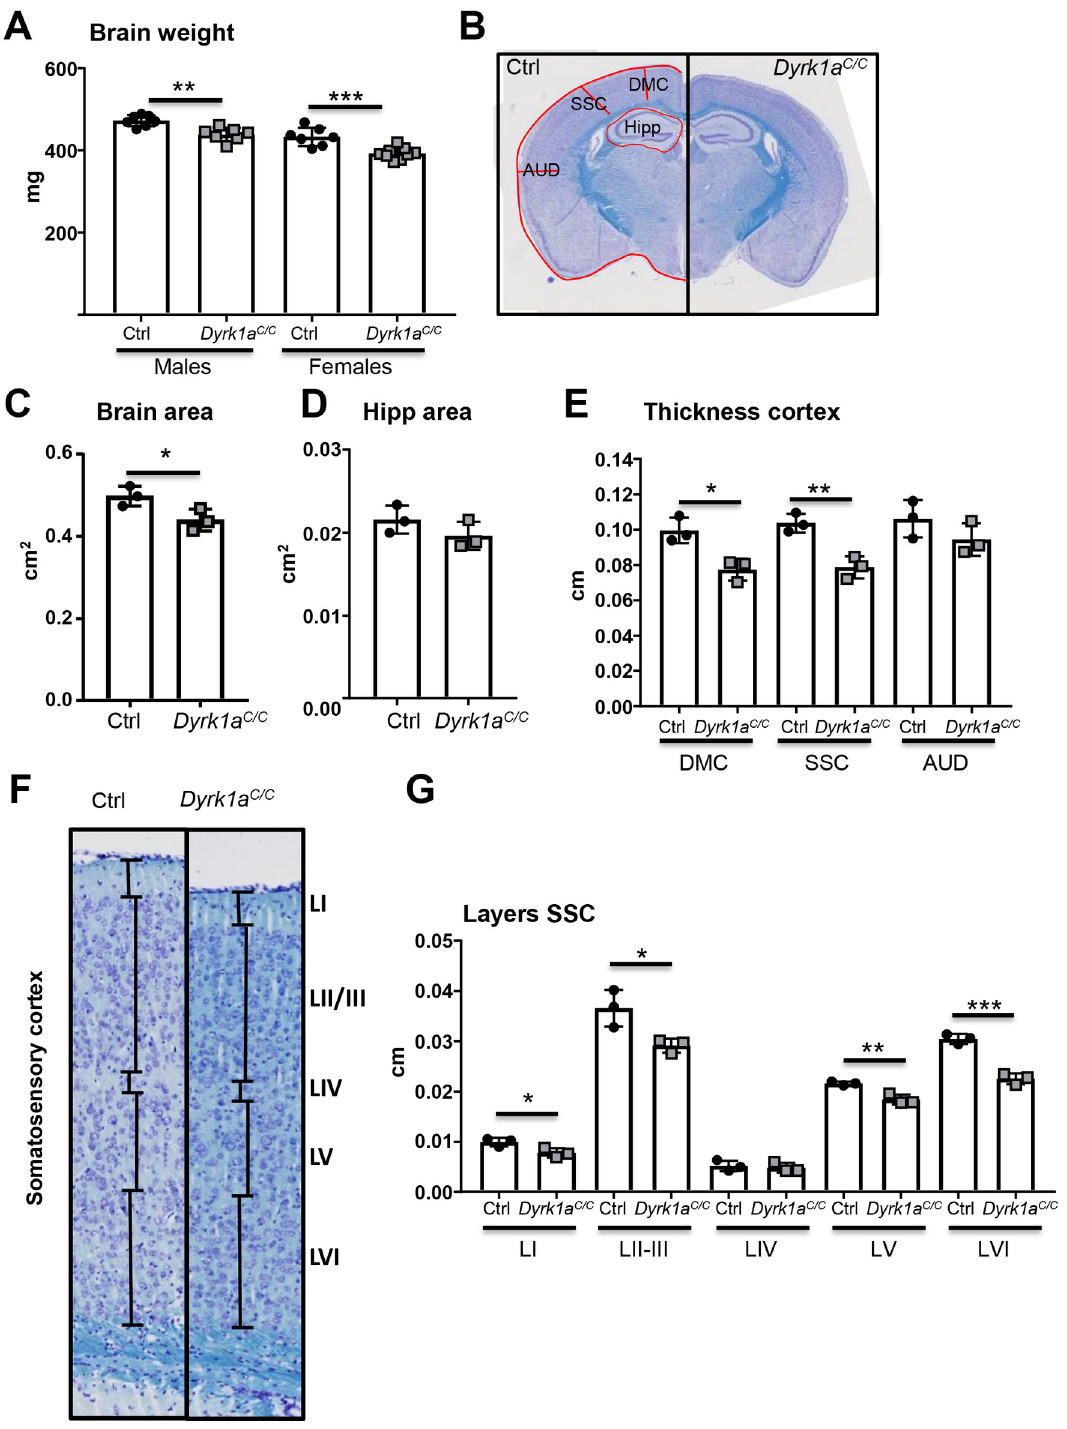
Fig 2. Consequence of Dyrk1a inactivation in glutamatergic neurons on brain morphology. (A) Brain weight from male and female mice aged 3 months old (n = 7–9 per genotype). (B) Representative coronal sections of control (Ctrl) (left) and Dyrk1a C/C (right) brains at Bregma -1.5 stained with cresyl violet and luxol blue that were used for measurements (Magnification 20X). (C) Dot plots of total brain area measurements (red line around the brain in B). (D) Dot plots of hippocampal areas (red area around hipp in B). (E) Measurements of the thickness of the cortex at the 3 levels represented by red lines in figure B. (F) Representative cresyl violet and luxol blue stained coronal sections of somatosensory cortex layers in control (Ctrl) and Dyrk1a C/C brains at Bregma -1.5.